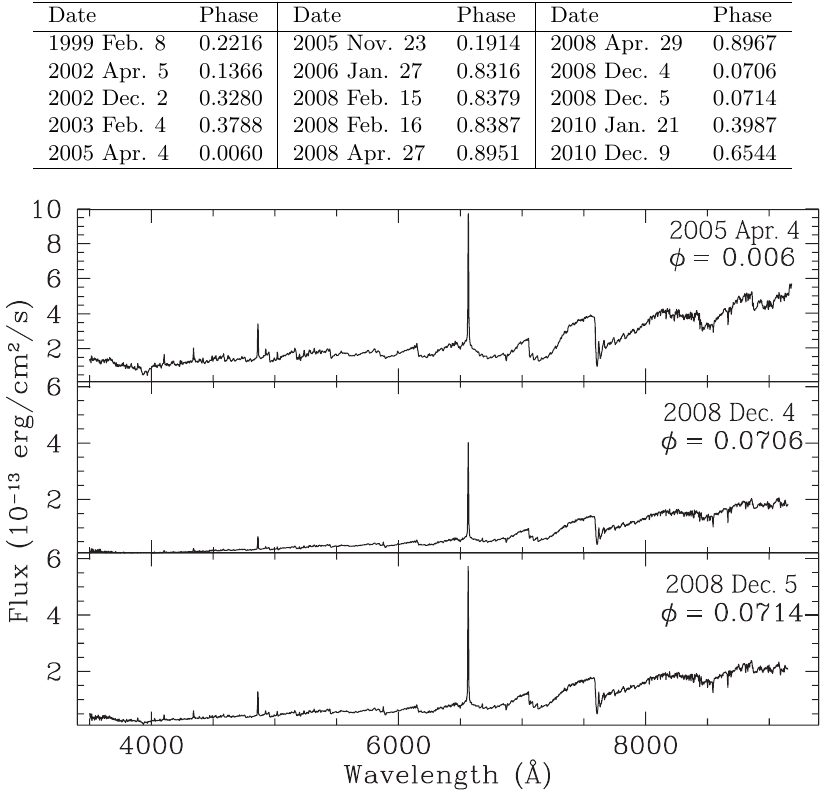
Table 1. Journal of observations of BX Mon.